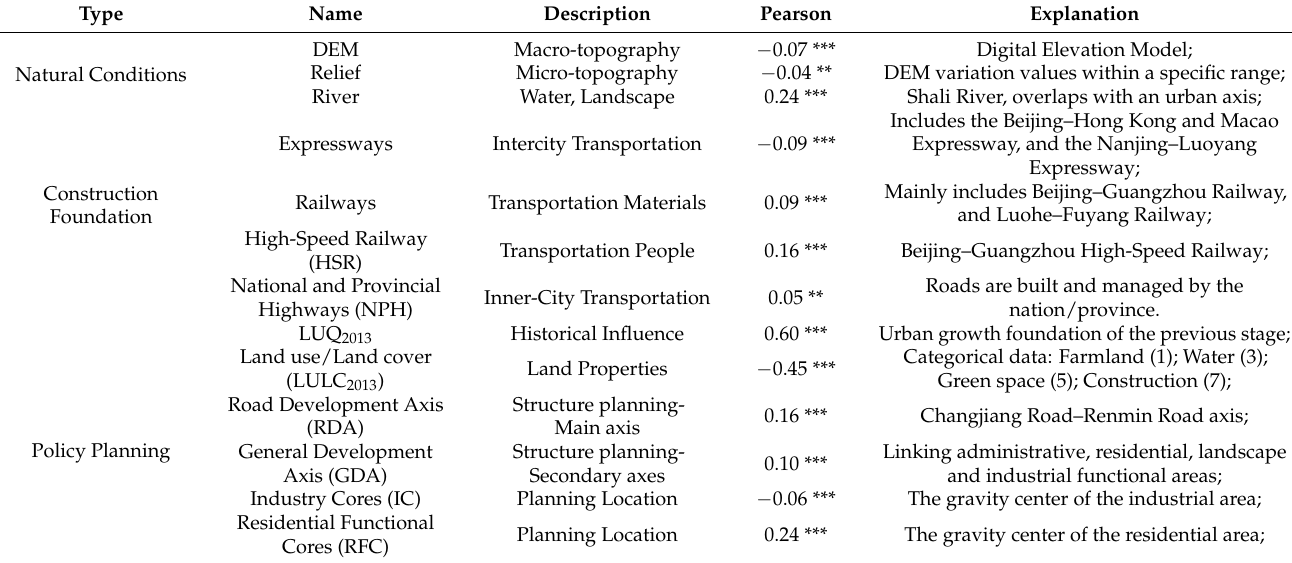
Table 2. 13 Factors that passed the Pearson and